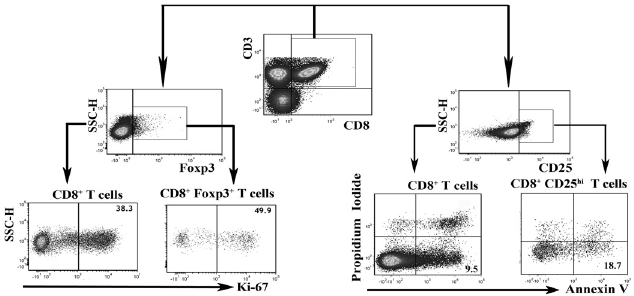
Fig 1. Representative dot plots show the gating strategy of the assays. In the proliferation assays, CD8 + Tregs were gated from CD8 + T cells (CD3 + CD8 + ) based on their positive expression of Foxp3, and the expression of Ki-67 by CD8 + T cells and CD8 + Tregs was then further analyzed. However, in the apoptosis assays, CD8 + Tregs were gated from CD8 + T cells (CD3 + CD8 + ) based on their high expression of CD25, and the apoptosis of CD8 + T cells and CD8 + Tregs gated on propidium iodide-negative and Annexin V-positive cells was then further analyzed.